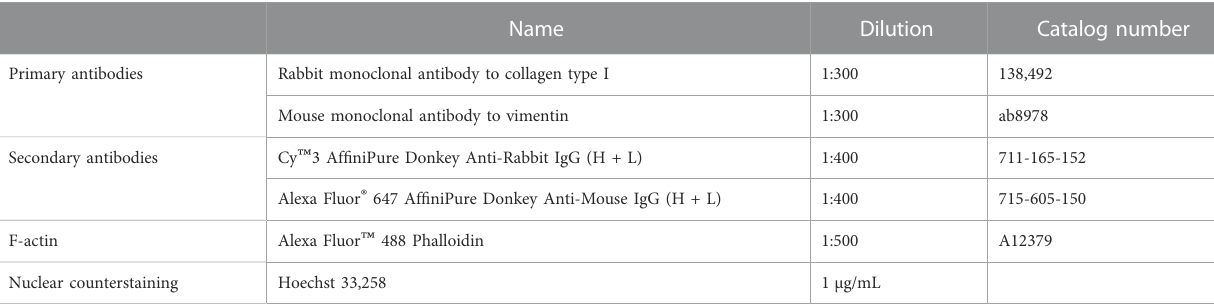
TABLE 1 List of reagents for